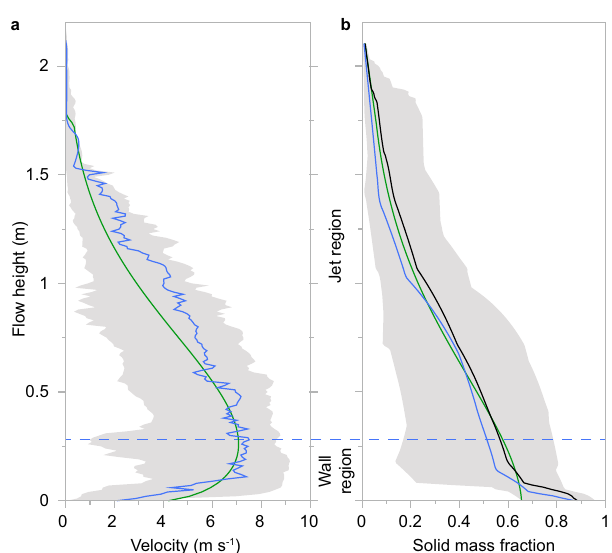
Fig. 2 Form and time-variance of vertical pro fi les of velocity and solid mass fraction. a typical example of the magnitude of fl ow velocity as a function of height (solid blue line) as obtained by particle image velocimetry at a static observer location of 3.12 m. The horizontal dashed blue line outlines the vertical position of the instantaneous velocity maximum that delineates the boundary between the wall and jet regions. The green line shows the fi t of the power-Gaussian velocity model (Eq. 2) to these data. The grey shaded area outlines the total temporal fl uctuations of the velocity magnitude as a function of height. b typical example of the fl ow ’ s solid mass fraction as a function of height (solid blue line) at a given time at a static observer location of 3.12 m. The green line shows the fi t to the measured data by the empirical model of ref. 34 developed for dilute η (cid:3) (cid:4) ¼ ϑ exp κη ν (cid:3) (cid:4) , where γ turbidity currents, which is de fi ned as ^ γ is solid S S mass fraction, η is non-dimensional height, and ϑ ; κ and ν are free fi tting parameters. In the wall region, the empirical model deviates from the experimental data due to fast settling mesoscale turbulence clusters that occur in our experimental pyroclastic surges 11,28,32 , but not in dilute turbidity currents. The time-integrated vertical pro fi le of solid mass fraction is presented as the black line. The grey shaded area outlines the total temporal fl uctuation in solid mass fraction as a function of height at the static observer